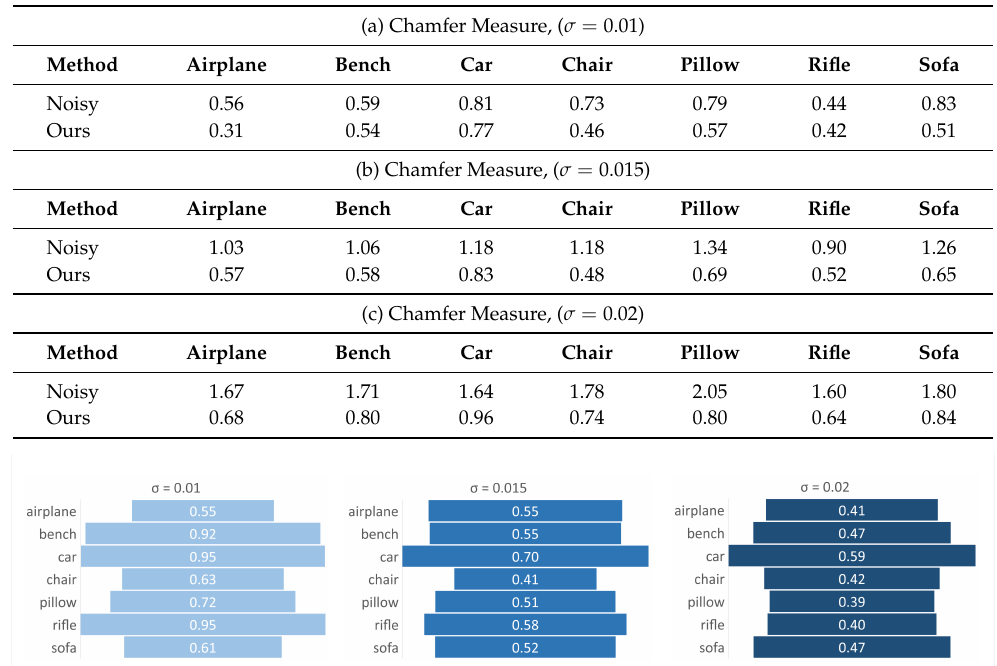
Table 2. Denoising performance of our method (CMD-Net) on the CMD-Net dataset is evaluated using the Chamfer Measure evaluation metric. The numbers in this table are C2C scores (see the metric in Section 4.1).